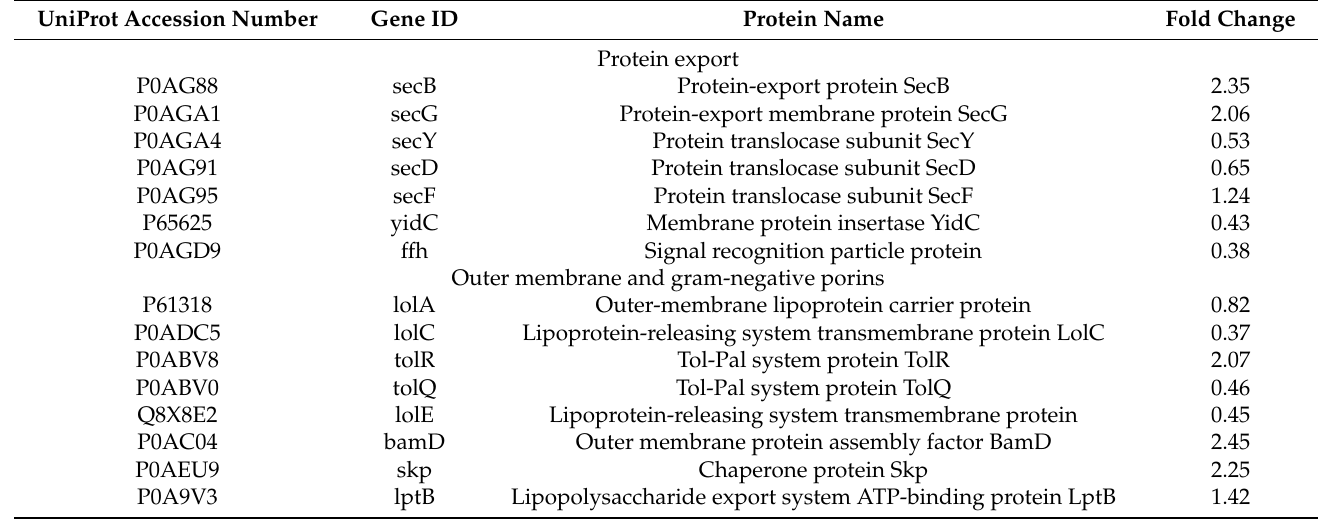
Table 1. Related differentially expressed proteins in network clusters of LA–CK.